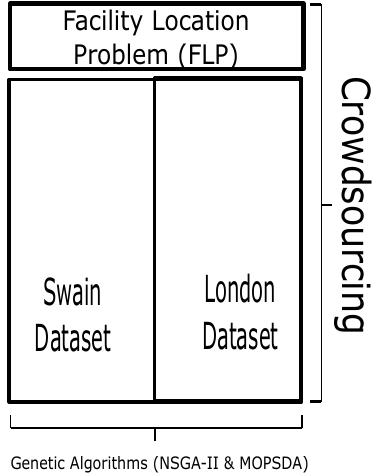
Figure 7. Experimental setup for evaluating the Facility Location Problem, using two datasets (Swain and London) commonly found in literature